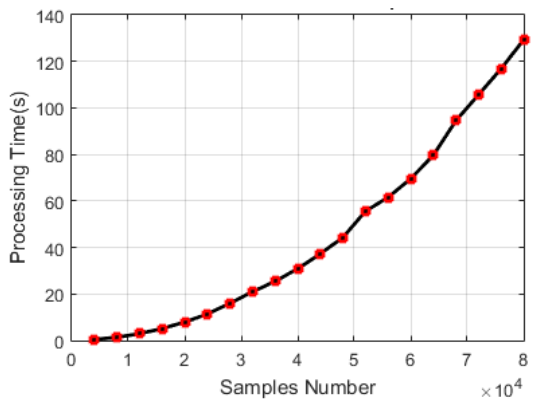
Figure 9. Execution time in terms of the number of samples. The execution time was calculated using the Matlab tictoc function and on a computer with an i5 processor and 4Gb of RAM.